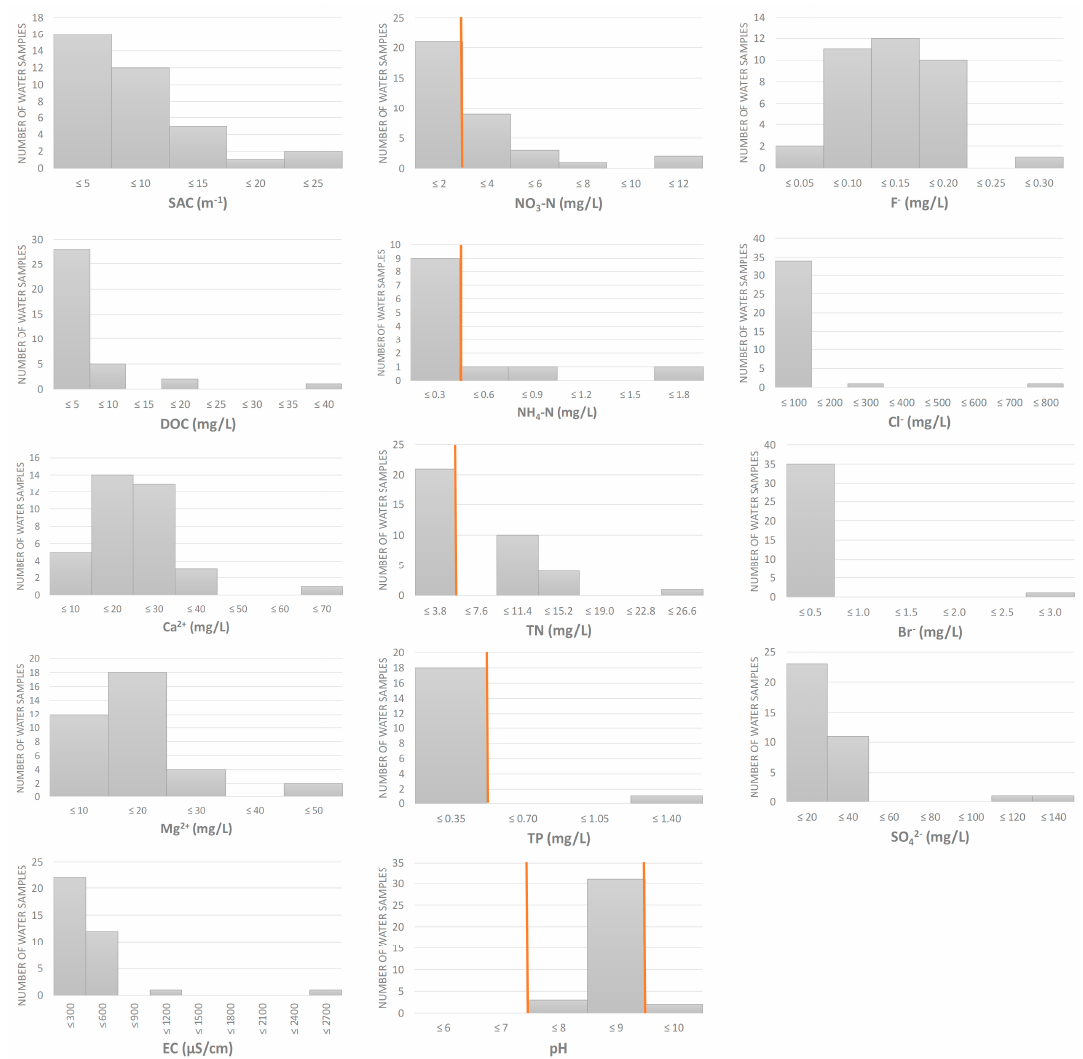
Figure 2. Physico-chemical properties of water samples ( n = 36). Orange lines represent the thresholds set by national legislation, available for some of the measured parameters [45], i.e., the upper threshold for NO 3 -N, NH 4 -N, TN and TP, and lower and upper thresholds for pH. SAC = spectral absorption coefficient, DOC = dissolved organic carbon, EC = electrical conductivity, TN = total nitrogen, TP = total phosphorus.